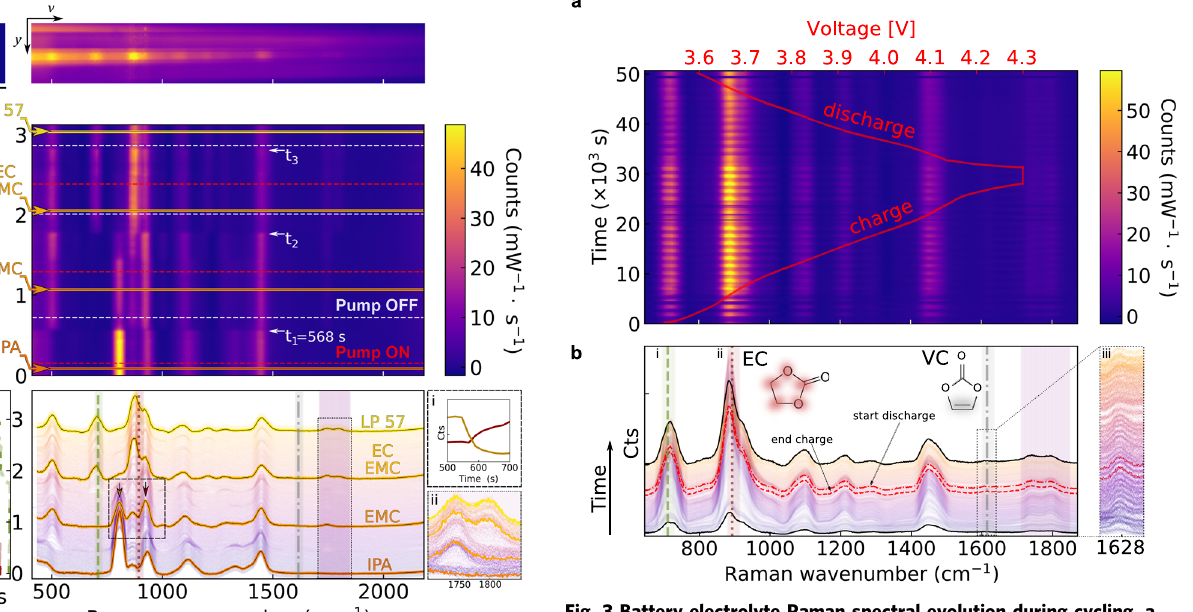
mechanical damage by the fi bre (Fig. 1d). The cell is sealed and fi lled with 100 µL of LP57 with 2 wt.% VC added. Details of the cell